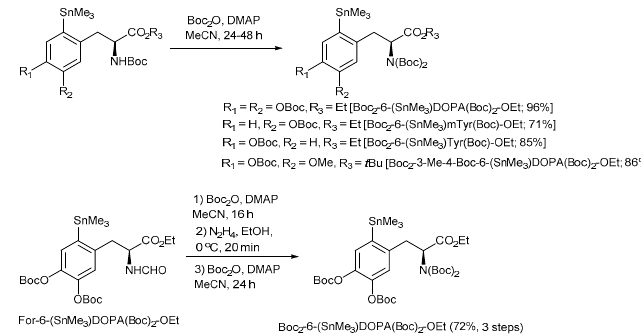
Figure 13. Preparation of N , N -diBoc protected radiolabeling precursors.